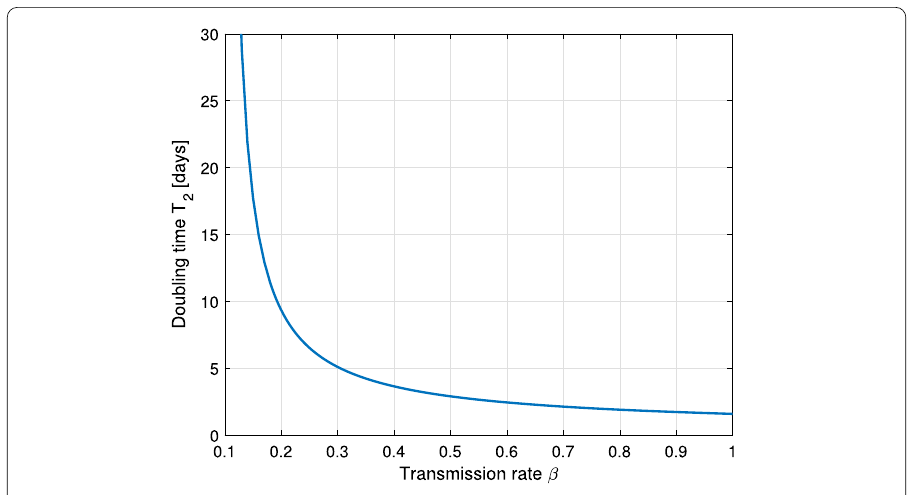
Figure 3 Plot of the doubling time T 2 in days versus the transmission rate β for fixed values ϑ = 1/2 and γ = 1/10. A reduction of the transmission rate from β = 0.8 to β = 0.2 accounts for a slow down of the infection from doubling time 2 days to 10